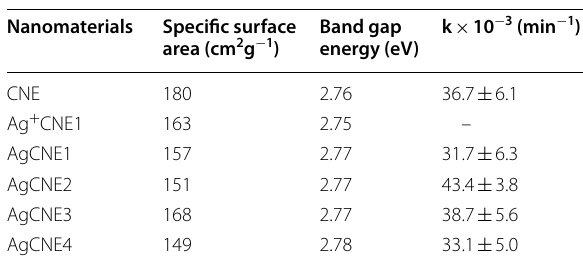
Table 3 The specific surface areas, pore sizes and band gap energies of AgCNE